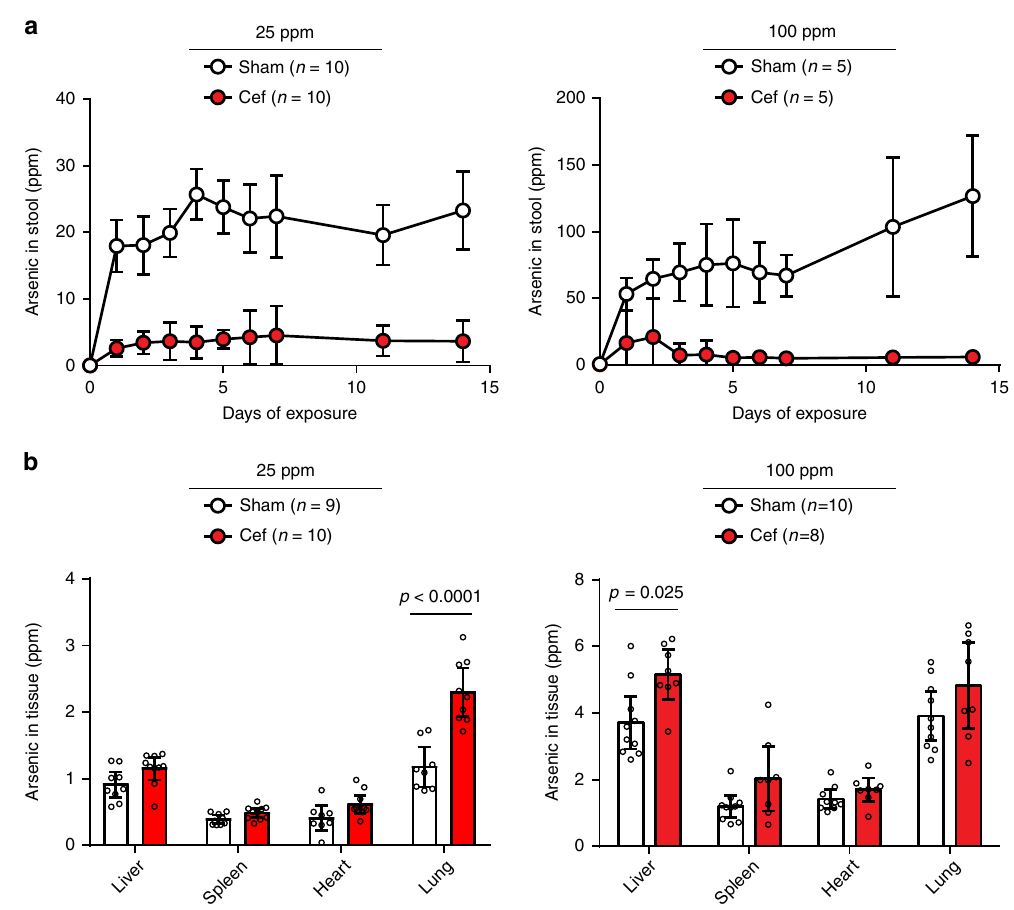
Fig. 1 Arsenic levels in feces and host tissues of wild-type C57BL/6 mice. Cefoperazone (Cef) and Sham treatments were initiated 48 h prior to inorganic sodium arsenate (iAs V ) exposure in drinking water at either 25 ppm (left) or 100 ppm (right). For 25 ppm exposures, a total of 20 mice were used in two replicate experiments ( n = 5 mice per treatment group; tissue from one mouse in Sham group was lost during processing). For 100 ppm exposures (right), a total of 10 mice were used to examine fecal excretion ( n = 5, Sham; n = 5, Cef) and an additional (replicate) experiment was added for tissue bioaccumulation (an additional 8 mice; n = 5, Sham; n = 3, Cef). Group-wise means are shown in all graphs (scatter plots and histograms) and error bars represent 95% con fi dence interval of the mean. a Signi fi cantly lower levels of arsenic were excreted in feces of Cef-treated mice beginning 24 h